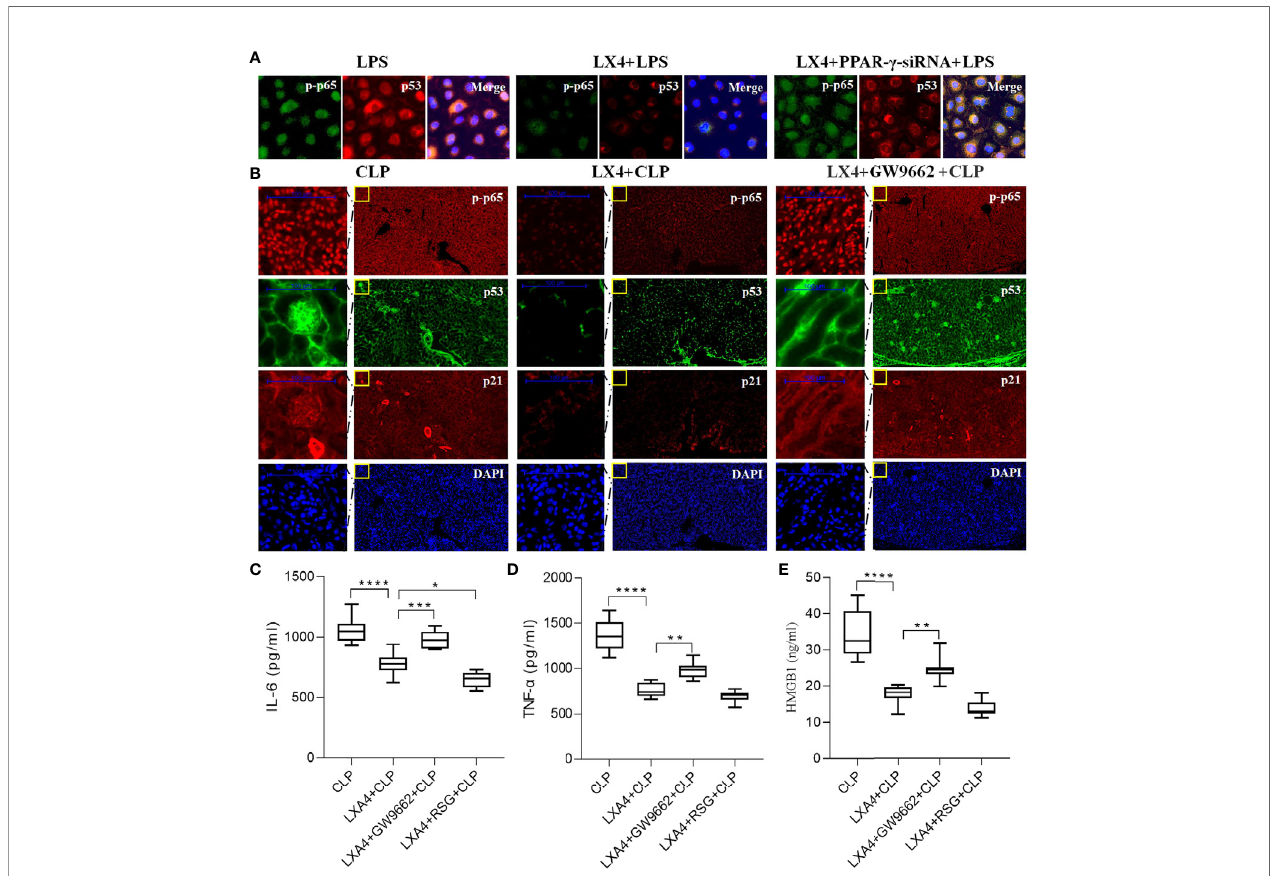
FIGURE 6 | LXA4 attenuates septic AKI via inhibition of PPAR- g /NF- k B pathway. Expression of p-p65, p53 and p21 in the neighbored section and levels of in fl ammatory cytokines in NRK52E cells and kidneys were also detected. (A) Expression of p-p65 and p53 in the NRK52E cells were detected by IF. (B) Expression of p-p65, p53 and p21 in the neighbored kidney sections were detected by IF. (C – E) levels of IL-6, TNF- a and HMGB1 at among the four groups. Data are presented as mean ± SE (n = 8). * p < 0.05; ** p < 0.005; *** p < 0.001; **** p < 0.0001; LXA4, Lipoxin A4; RSG, Rosiglitazone; CLP, cecal ligation and puncture; IL-6, interlecukin-6; IL-8, interlecukin-8; TNF- a , tumor necrosis